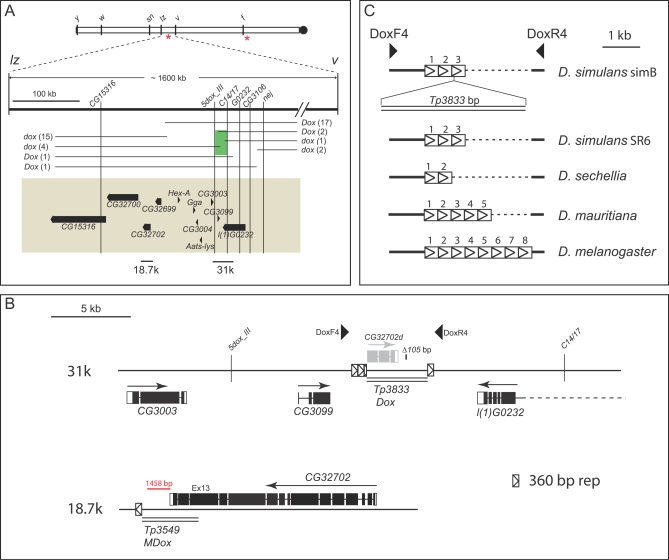
Fine Mapping and Positional Cloning of dox
(A) The crossover intervals and the sex-ratio phenotype of the definitive 43 recombinants between lz and v. dox: normal sex ratio; Dox: sex ratio distorted. The number of similar recombinants is included in parenthesis. The seven most informative recombinant events fall within the interval 5dox_III and C14/17 (green region). Some of the annotated genes in D. melanogaster in this region are also shown (yellow region) (http://www.flybase.org/cgi-bin/gbrowse/dmel/). The two regions marked as 18.7k and 31k in the D. simulans simB strain have been sequenced from PCR products and phage clones. * represents Dox at left and E(Dox) at right.(B) Annotations of the 18.7k and 31k regions in D. simulans. Genes orthologous to D. melanogster are shown (arrow: orientation of transcripts; line: introns; open box: untranslated region of mRNA; filled box: coding sequence). A transposition of 3,833 bp (double lines, Tp3833) in the Dox region can be recognized as originating from the downstream region of CG32702 (Tp3549). The positions of the 105-bp deletion (Δ105) and the exons of CG32702 within Tp3833 (CG32702d in gray) are shown. A repetitive sequence with a 360-bp consensus has also been recognized in both regions. Primers DoxF4 and DoxR4 were used to amplify this region for cross-species comparisons. In the Tp3549 region, a sequence of 1,458 bp (red line) has no homolog in D. melanogaster CG32702.(C) Comparison of the Dox region among several species of the D. melanogaster subgroup. Sequences from eight strains of D. simulans, and one strain each from D. sechellia (3588), D. mauritiana (w12), and D. melanogaster (y; cn bw sp) were compared. Tp3833 is present in seven strains of D. simulans (represented by simB) but is absent in SR6. It is also absent in all other species examined.